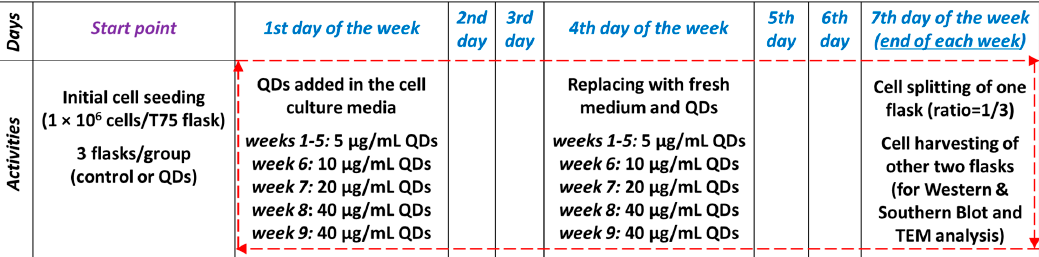
Figure 2. Schematic representation of the long-term exposure (9 weeks of 7 days each) of MRC-5 cells to Si/SiO 2 QDs. The human lung fibroblasts were cultivated on three flasks of 75 cm 2 per group (control or QDs) at an initial density of 1 × 10 6 cells/flask (“Start point”). The QDs were added in the culture media at 24 h after each seeding (“1 st day of the week”) in order to maintain a proper cell adhesion on the flasks’ surface. When culture medium was changed (“4th day of the week”), the QDs were added again in the fresh culture media. The passage of cells cultured in one flask was performed at the 7th day of the week (“the end of each week”), the split ratio being 1/3. The cells from the other 2 flasks were collected for Western and Southern blots and for TEM analysis.